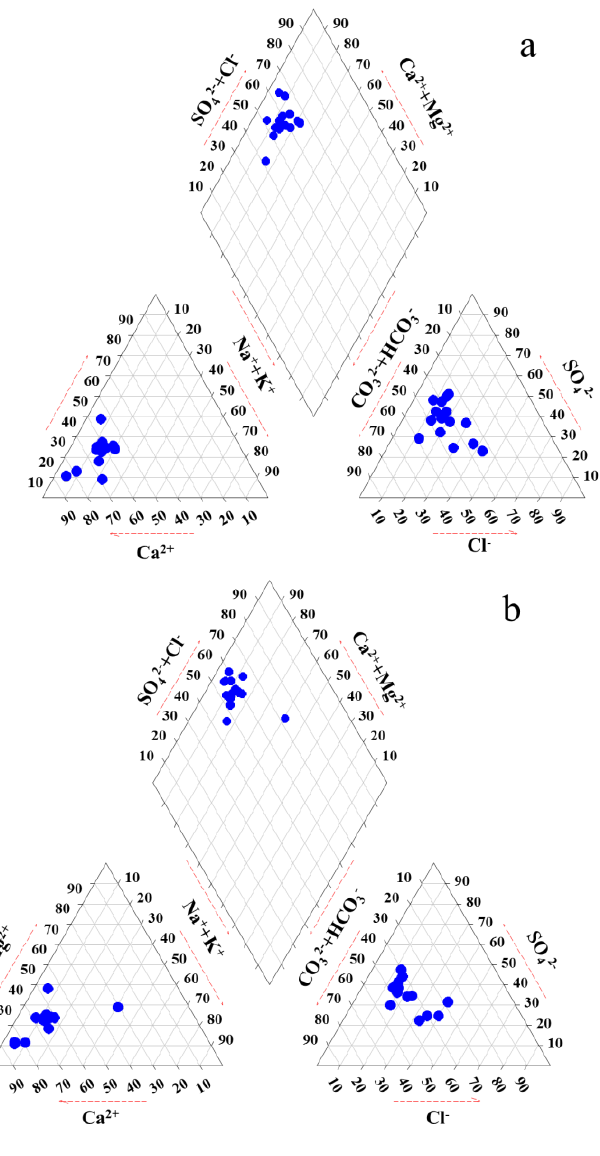
Figure 2. Piper diagram showing the chemical composition of the groundwater in the dry ( a ) and flood ( b ) season. flood ( b )